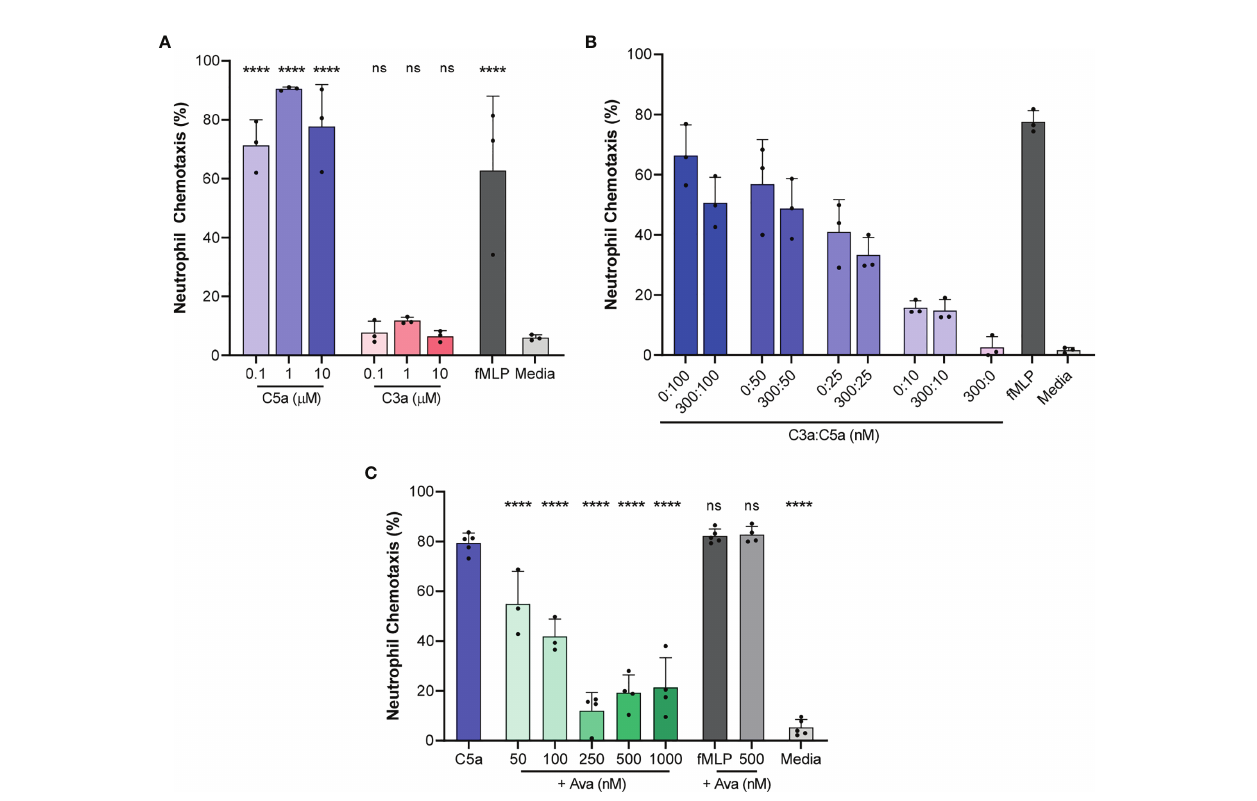
FIGURE 2 | Chemotaxis of isolated neutrophils towards C5a and C3a and the effect of AVA on chemotaxis. (A) The percentage of neutrophils migrating directionally towards increasing concentrations of C5a and C3a compared to media alone (HBSS with 0.5%BSA, N=3, ****p < 0.0001; One-way ANOVA with Dunnett ’ s test) (B) C3a inhibits neutrophil chemotaxis towards C5a, C5a effect is dependent on concentration, and there is no interaction effect between C3 and C5a. (N=3 donors, p < 0.005, Repeated measures, two way ANOVA, with Sidak ’ s correction for multiple comparisons). (C) Percentage of neutrophils migrating directionally towards C5a (100 nM) after treatment of neutrophils with C5aR1 antagonist AVA (N=3, 4 or 5, each dot on the plot represents one experiment, ****p < 0.01 for comparisons to C5a control; ns represents not statistical signi fi cant. One way ANOVA with Dunnett ’ s multiple comparison test with single pooled